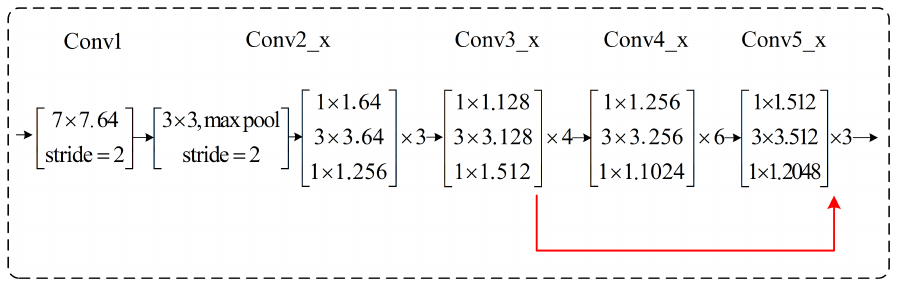
Figure 3. ResNet50 network structure; the red arrow indicates the path from C 3 to C 5